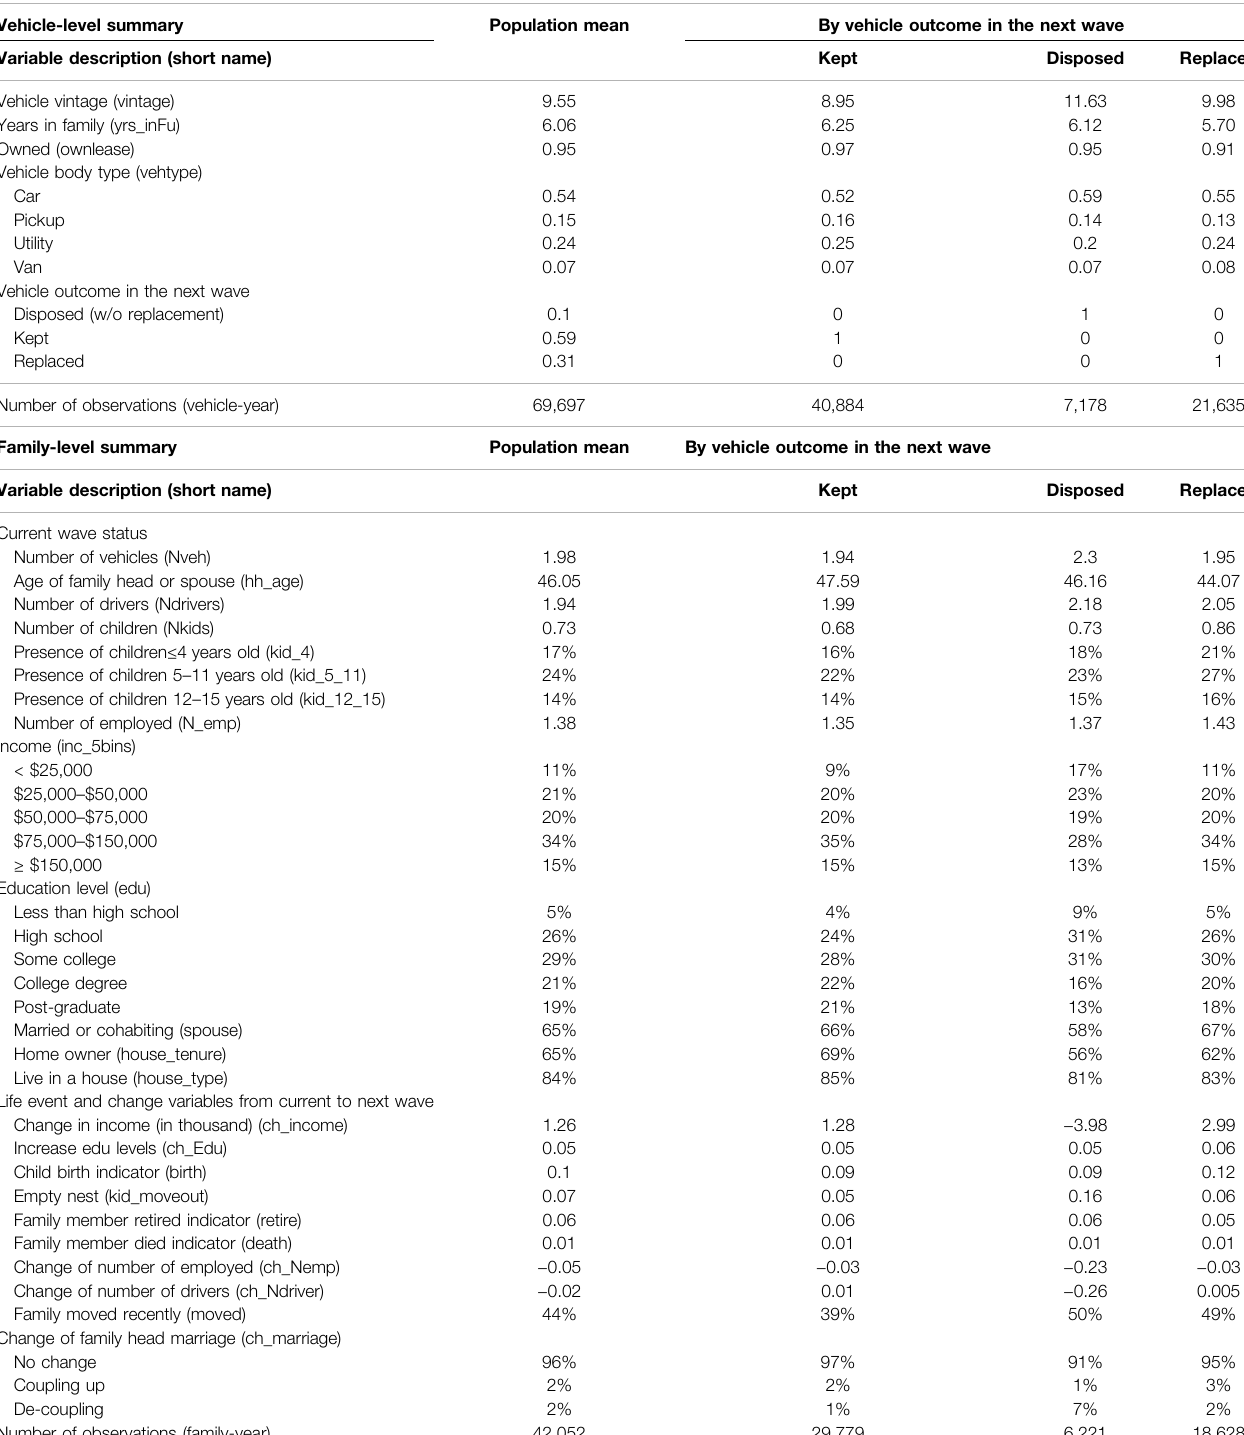
TABLE 1 | Descriptive Statistics of Vehicle Speci fi c and Family level Variables for the Full Sample and by Vehicle